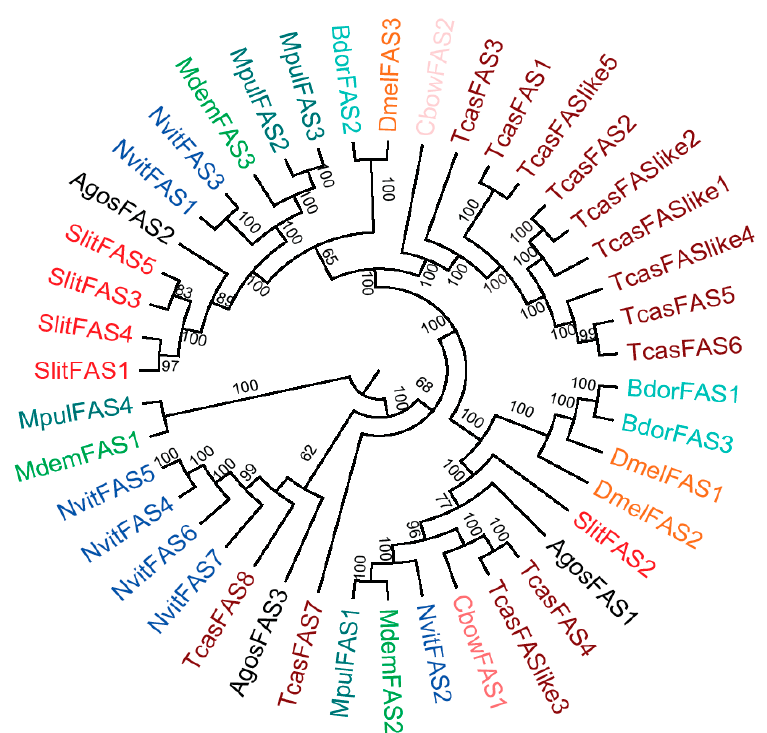
Figure 2. Phylogenetic relationships of FASs amino acid sequences. Spodoptera litura (Slit), Tribolium castaneum (Tcas), Microplitis demolitor (Mdem), Nasonia vitripennis (Nvit), Colaphellus bowringi (Cbow), Aphis gossypii (Agos), Drosophila melanogaster (Dmel), Bactrocera dorsalis (Bdor), and Meteorus pulchricornis (Mpul). The different colors indicate FASs in different insect species. Details of FAS protein sequences are listed in Table S2 .